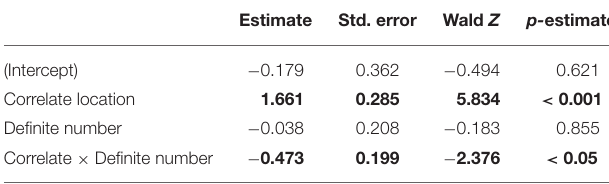
TABLE 2 | Experiment 1: results of linear mixed effects regression model.